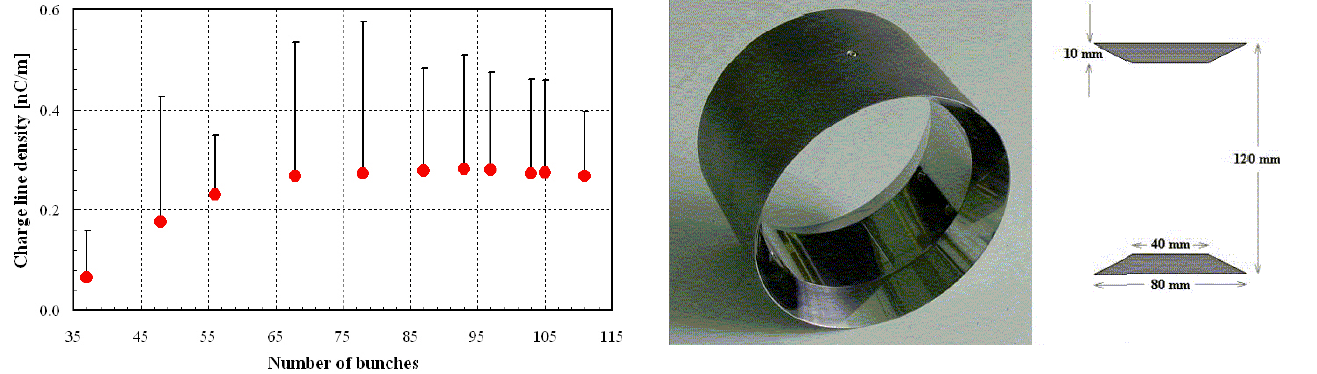
FIG. 20. (Color) Simulated average (red dots) and peak (bars) electron cloud density as a function of the number of bunches where the total intensity is held constant.